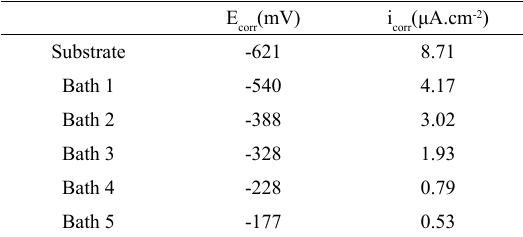
Figure 12. Potentiodynamic polarization curves of the coatings obtained in baths with different tungsten concentrations after annealing at 400 ºC for 1 h. ) and corrosion current densities Table 8. Corrosion potentials (E corr (i ) obtained from the polarization curves shown in Fig. corr